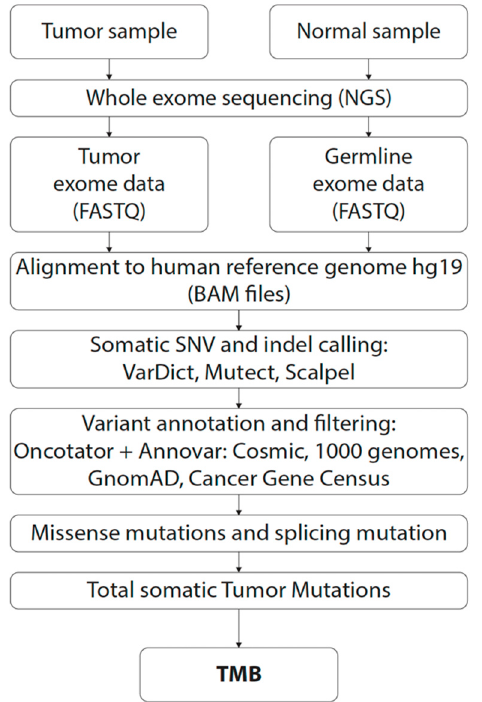
Figure 3. Workflow for tumor mutational burden (TMB) assessment by WES in this study.